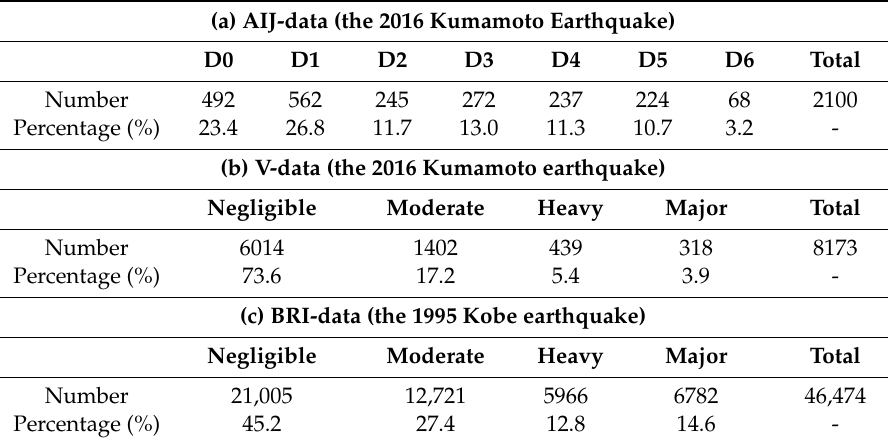
Table 2. Numbers of buildings in damage